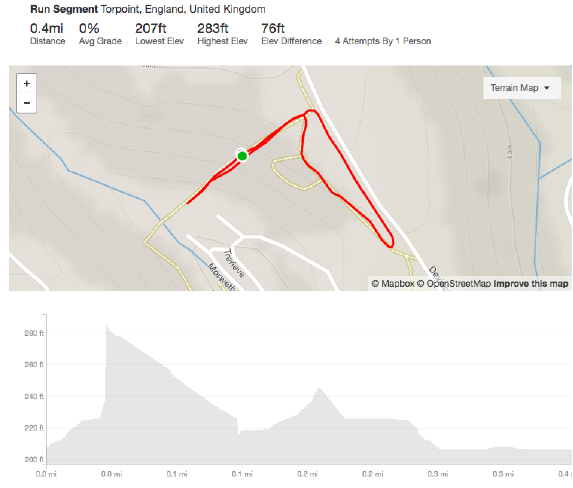
Figure 2. Course and elevation profile—note extremely steep grade in sections.